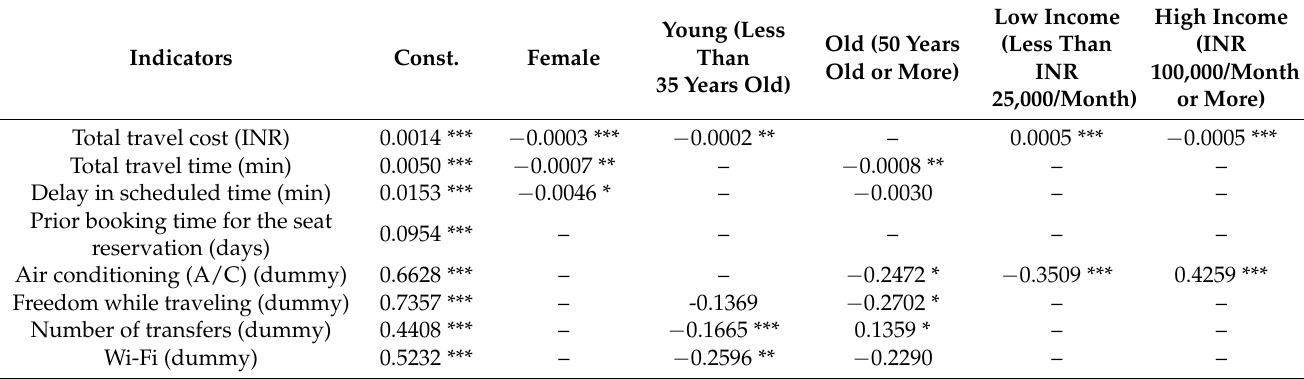
Table 9. Estimated parameters of quality of travel (QOT)